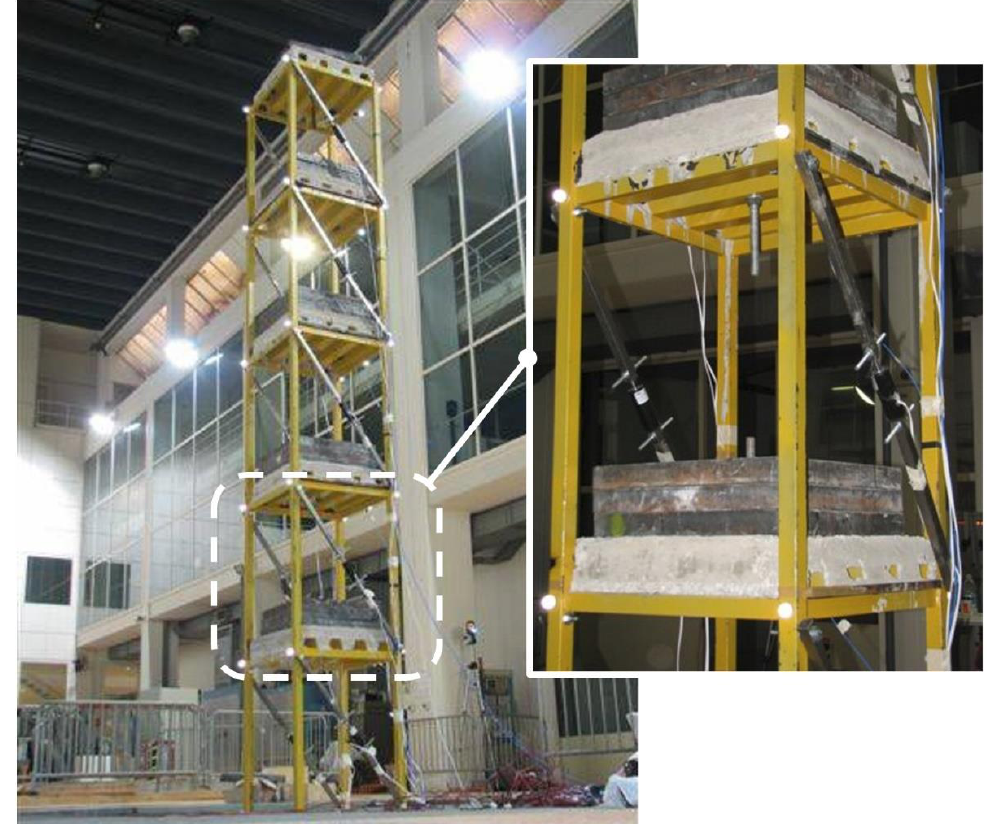
Figure 43. Reference structure and dissipative bracings (VSS).